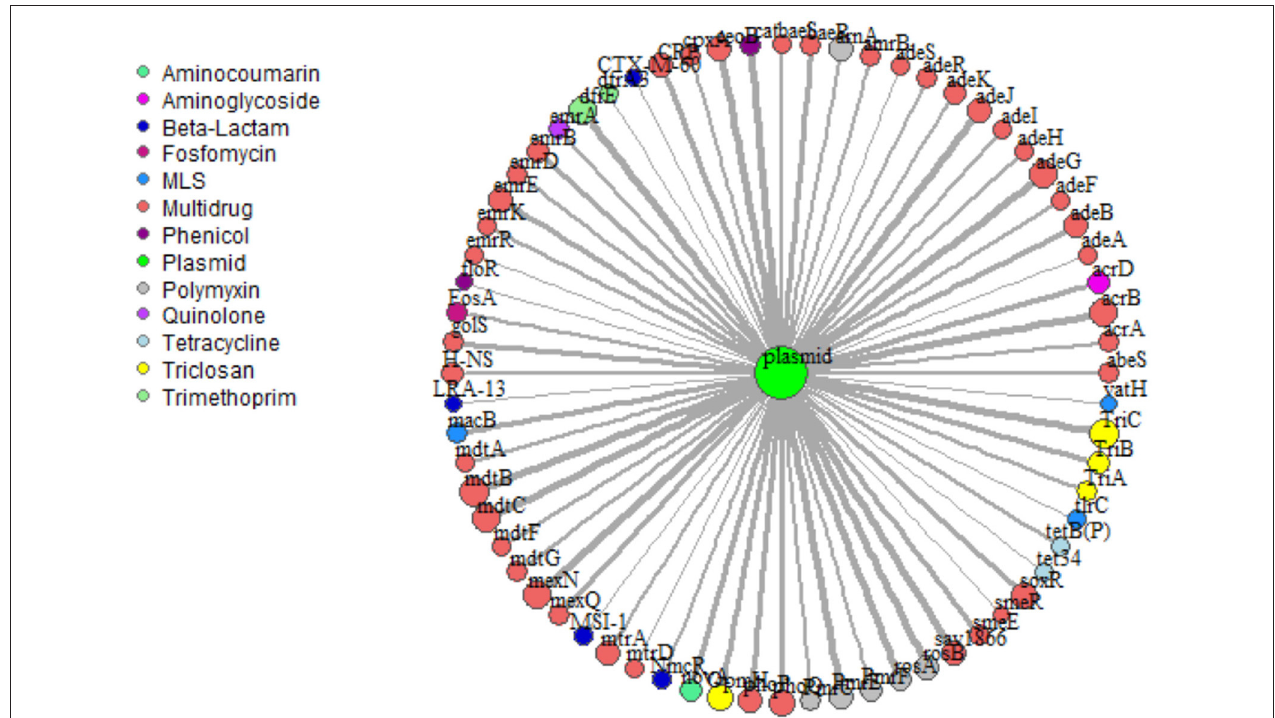
FIGURE 6 | Network analysis predicting frequency of co-occurrence of ARGs (annotated using CARD 1.2.1) with plasmid-associated genes (annotated against ACLAME database) based on assembled metagenomic data. Relative size of node and thickness of the line is scaled according to frequency of co-occurrence. In total there were 69 plasmid-associated genes (nodes) consisting of 13 distinct drug classes. Edges were filtered to <